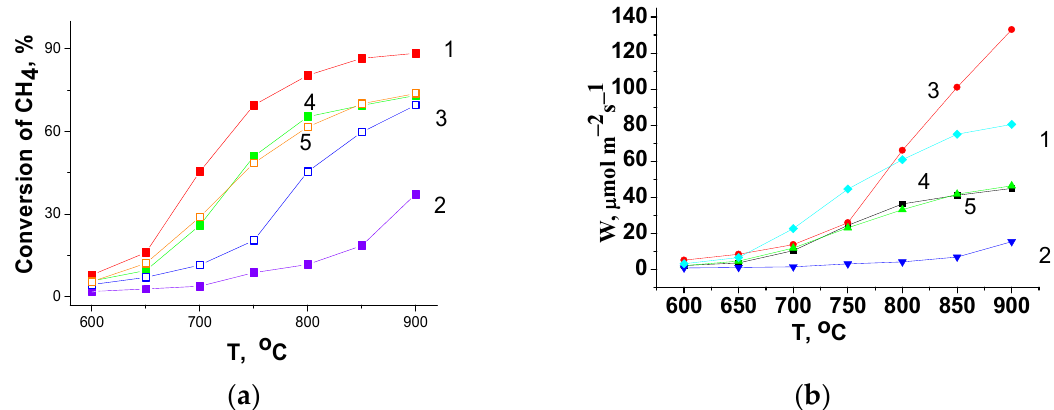
Figure 7. Conversion of methane ( a ) and CH 4 oxidation rates ( b ) for the as-prepared samples. The gas mixture (1% CH 4 + 9%O 2 + 90%He) flow rate is 60 L/h and contact time ( τ ) is 0.006 s. Curves designations correspond to sample numbers (Table 1).